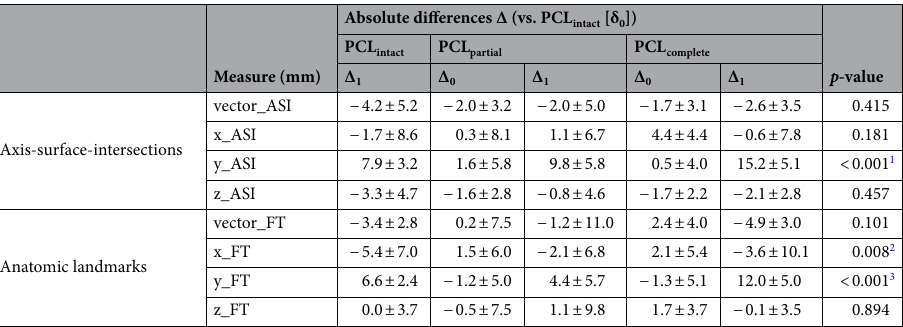
Table 1. Absolute differences of 3D vector measures to compute knee joint changes as a function of PCL injury and loading. For all 3D computed vector measures, absolute values for each PCL-condition (PCL intact — intact PCL; PCL partial —after partial PCL transection; PCL complete —after complete PCL transection) and loading configuration (unloaded [δ 0 ] and loaded [δ 1 ]) were related to absolute values of δ 0 [PCL intact ] to determine absolute changes (Δ x ) for each PCL condition (Δ x [PCL-condition] = δ x [PCL-condition]-δ 0 [PCL intact ]). Data are presented as means ± standard deviation. Statistical analysis was based on repeated measures analysis-of- variance and significant findings are indicated in bold type. Sequential numbers in square brackets indicate the corresponding post-hoc details as given in Supplementary Table 1. For detailed explanations of the vector-based 3D measurements, please refer to Supplementary Fig. 1. Abbreviations: PCL—posterior cruciate ligament. Vector_ASI—vector between the femoral and the tibial axis-surface-intersection. Vector_FT—vector between the apex of the femoral trochlea and the centre of the tibial tuberosity. Vector projections on Cartesian x-axis (i.e., anteroposterior dimension; “x_FT”, “x_ASI”), y-axis (i.e., mediolateral dimension; “y_FT”, “y_ ASI”), and z-axis (i.e., craniocaudal dimension; “z_FT”, “z_ASI”) are given, too.